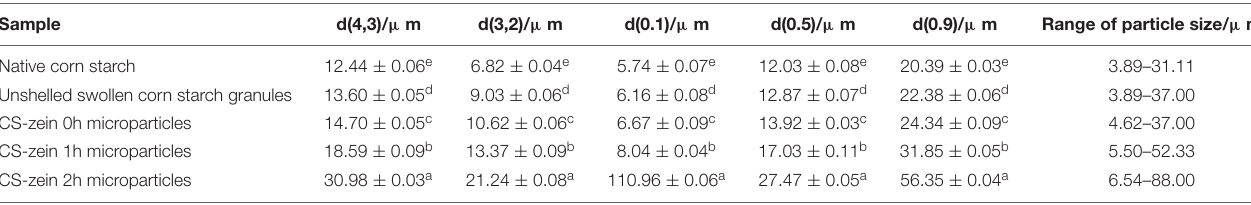
Values indicate means ± SD of three replicates. Data in the same column with different letters are substantially different (p < 0.05).